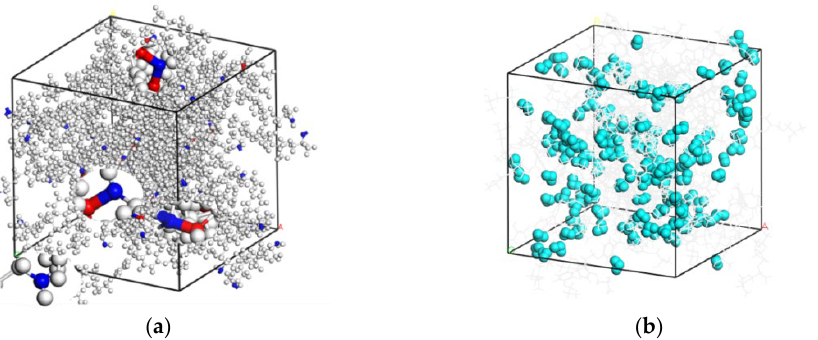
Figure 4. DGEBA/JEFFAMINE ® -D230 cell with a degree of cross-linking of 85.4% ( a ) without water molecule and ( b ) with moisture concentration of 12 wt.%. All the N are blue. The cross-linked C is red. Some of the cross-linked bonds are magnified. The light blue molecules are water molecules.